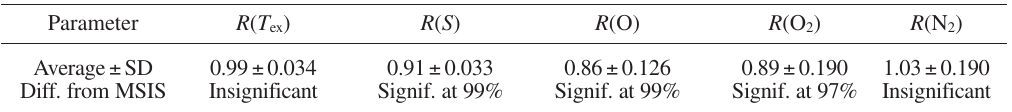
Table 4.II. Average ratios of calculated thermospheric parameters to MSIS-86 values over the sunlit hours. The difference from MSIS values is estimated with the Student criterion.